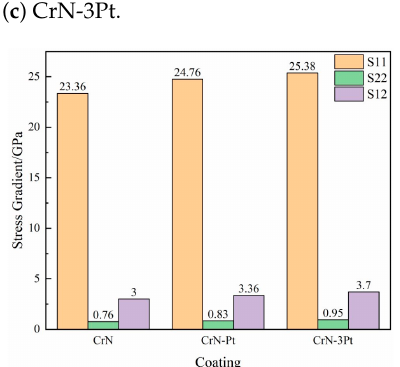
Figure 14. Isotropic residual stress distribution on the surfaces of three coatings. ( a ) CrN; ( b ) CrN-Pt; ( c ) CrN-3Pt.